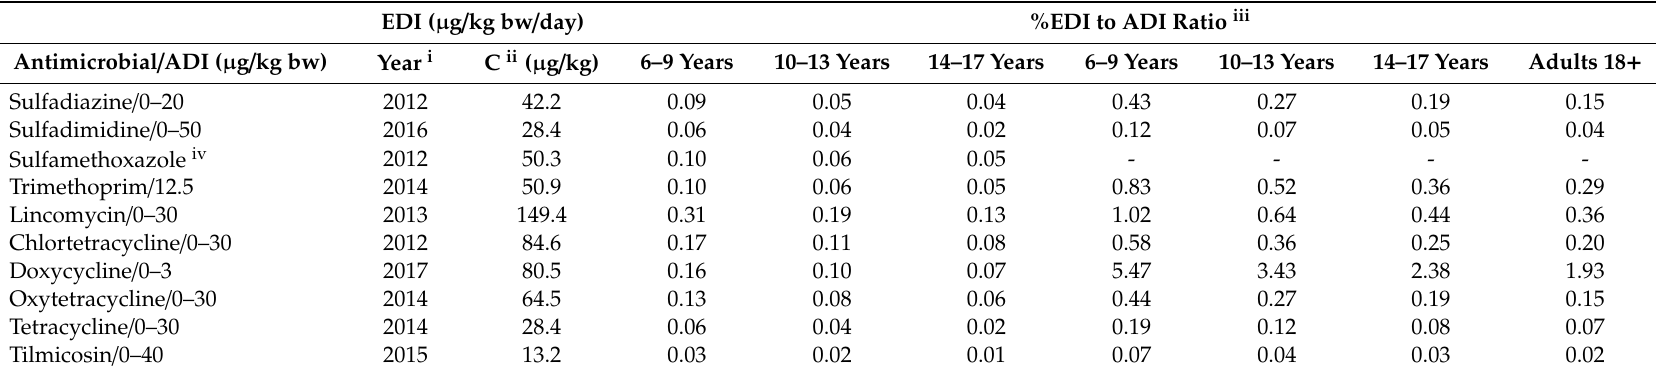
Table 4. Estimated daily intake values (EDI) and percentage of EDI to acceptable daily intake (ADI) ratio for male children and adolescents using the maximum geometric mean concentration.